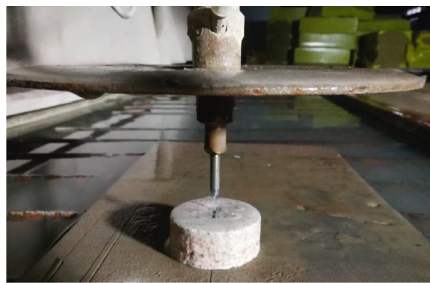
Figure 4: Pre-existing flaws preparation in sandstone BD specimens using a water jet cutting machine.